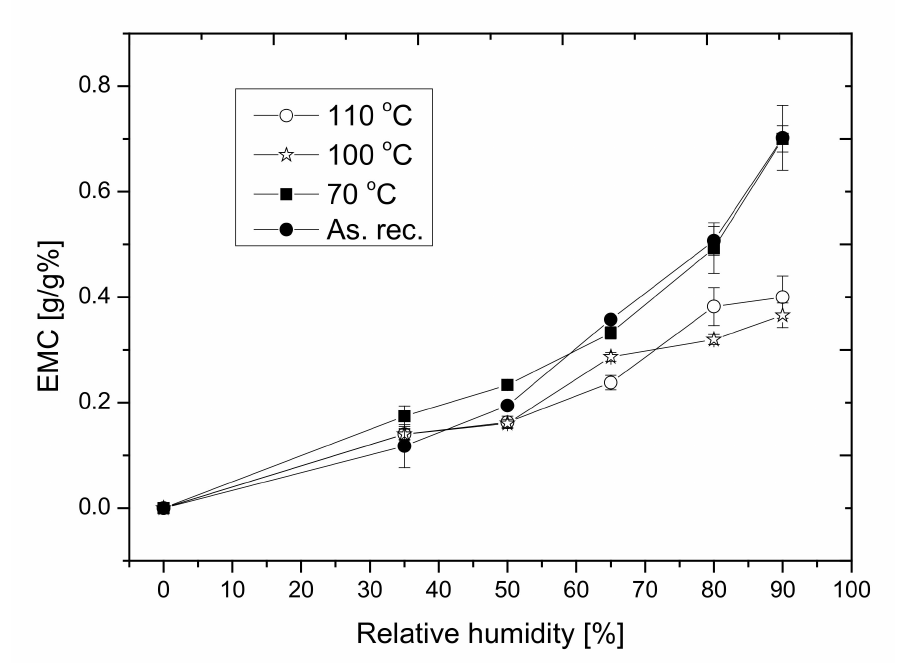
Figure 9. The sorption isotherms.